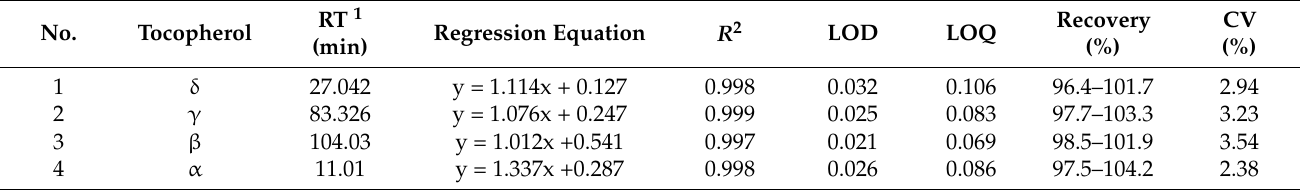
Table 3. Parameters of method validation for tocopherols 1